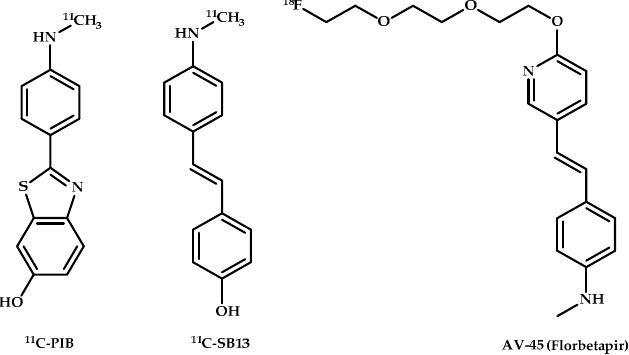
Figure 1. Pittsburgh compound B (PiB), [11C]4-N-Methylamino-4 ′ -hydroxystilbene (SB–13), and Florbetair (AV–45), AD PET imaging